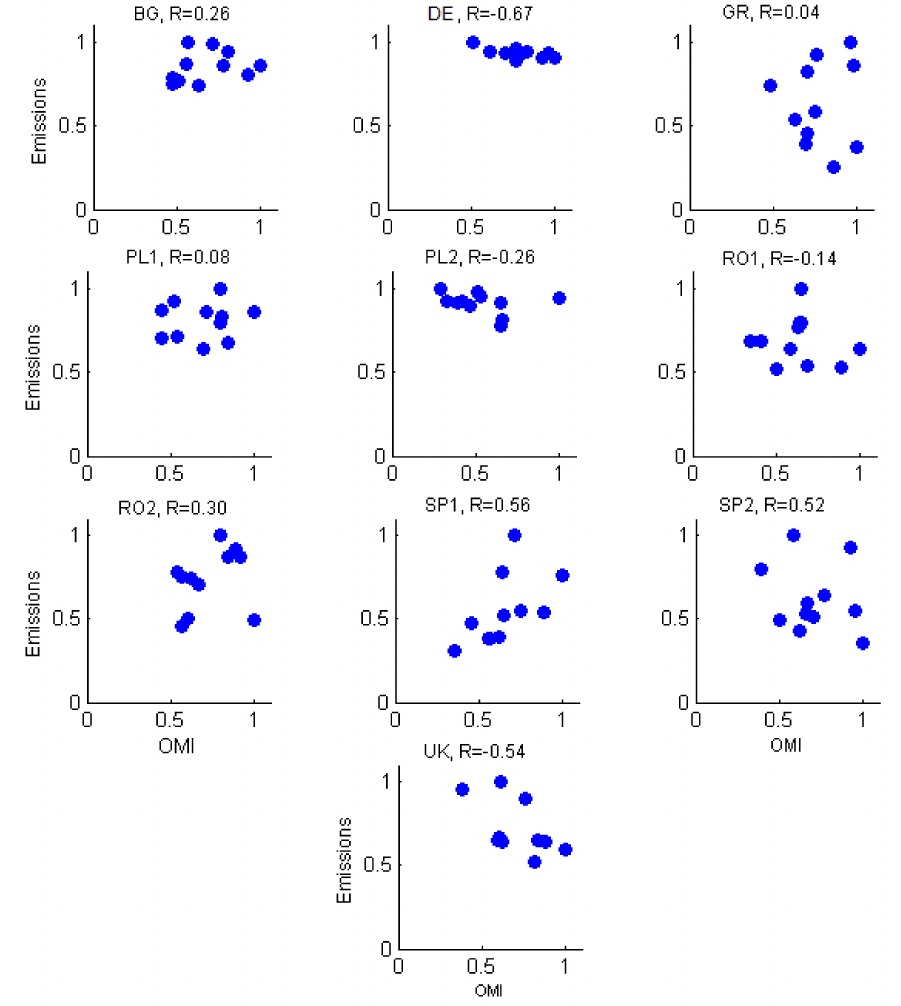
Figure 6. Scatter plots of OMI measurements vs. reported emission for NO 2 (normalized